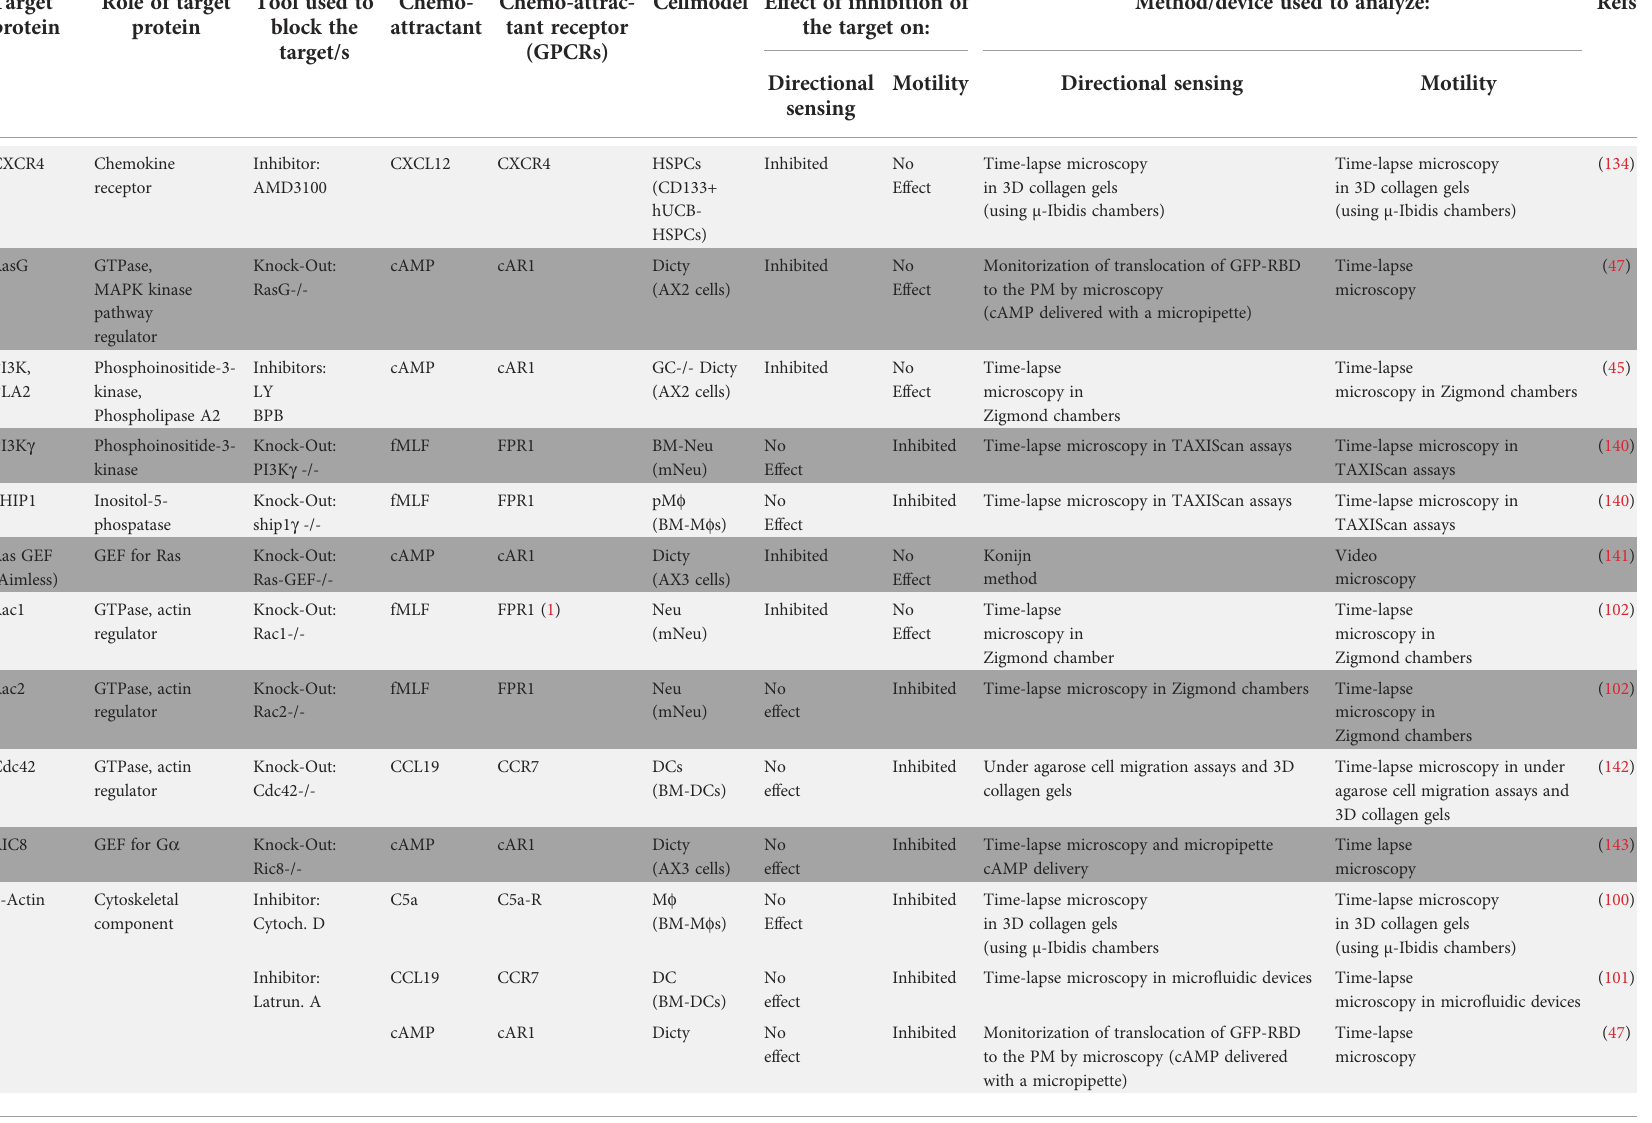
TABLE 3 Independent regulation of directional sensing and motility downstream of the G-protein-coupled receptor family of chemoattractant receptors. Target